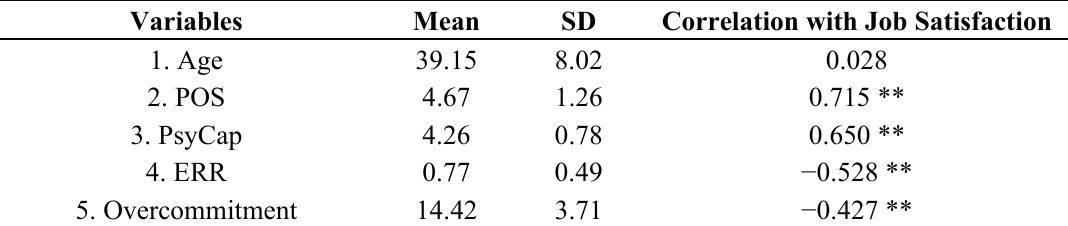
Table 2. Means, standard deviations (SD), and correlations of continuous variables with job